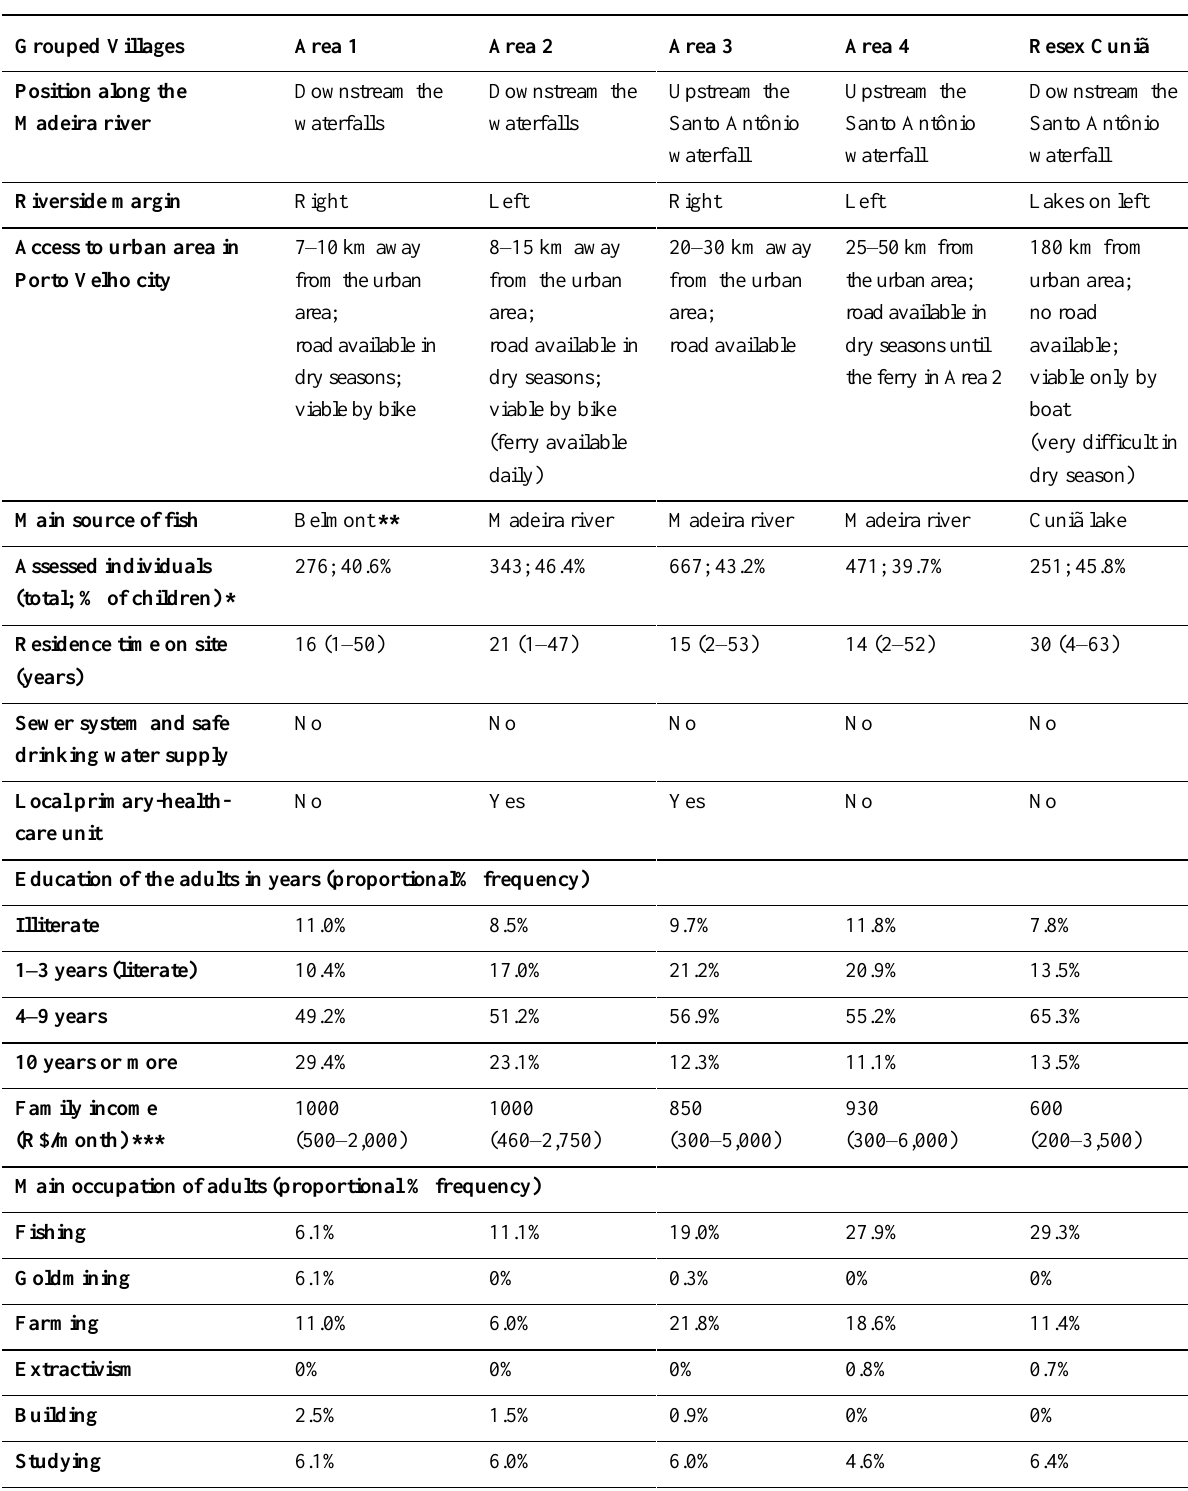
Table 1. Characteristics of the study